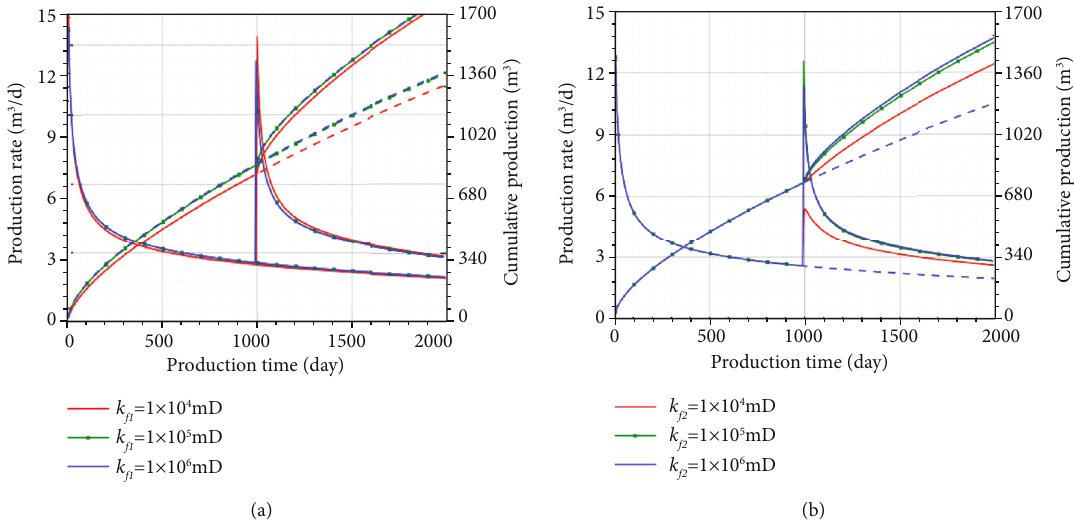
Figure 10: Performance of the refractured well with (a) di ff erent initial fracture permeability (b) di ff erent refracture